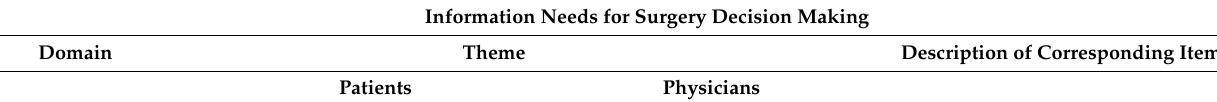
Table 2. Qualitative results for the surgery decision regarding “thyroid lobectomy or total thyroidectomy”. Expressed needs, preferences, and values of patients and of physicians treating patients with